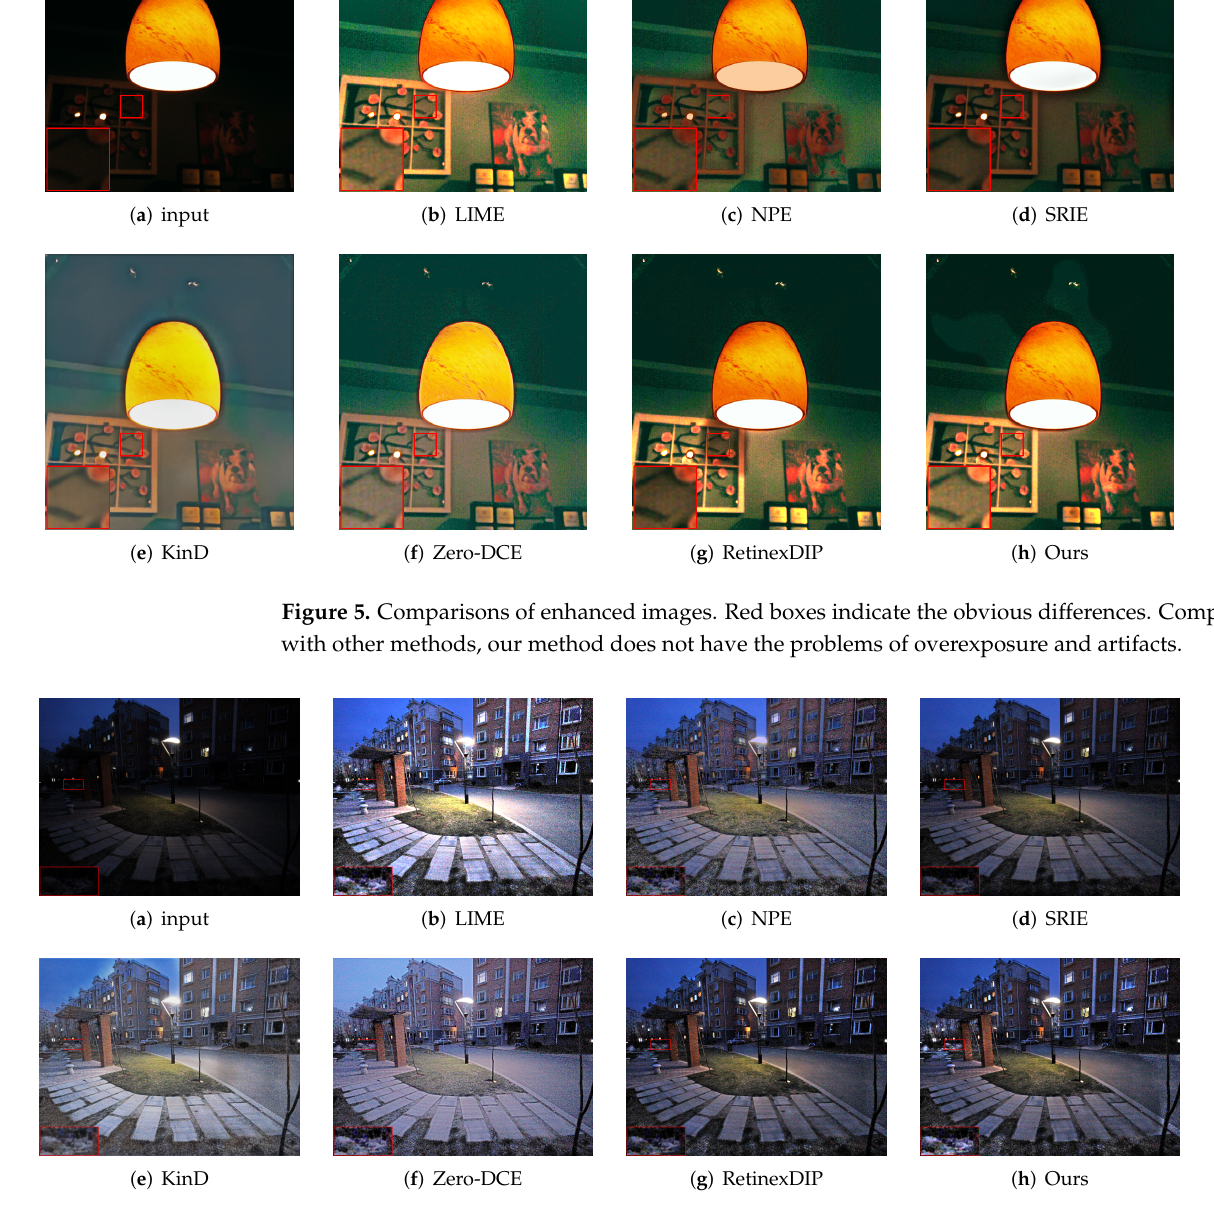
Figure 6. Comparisons of enhanced images. Red boxes indicate the obvious differences. Compared with other methods, our method improves the contrast effectively and maintains the natural